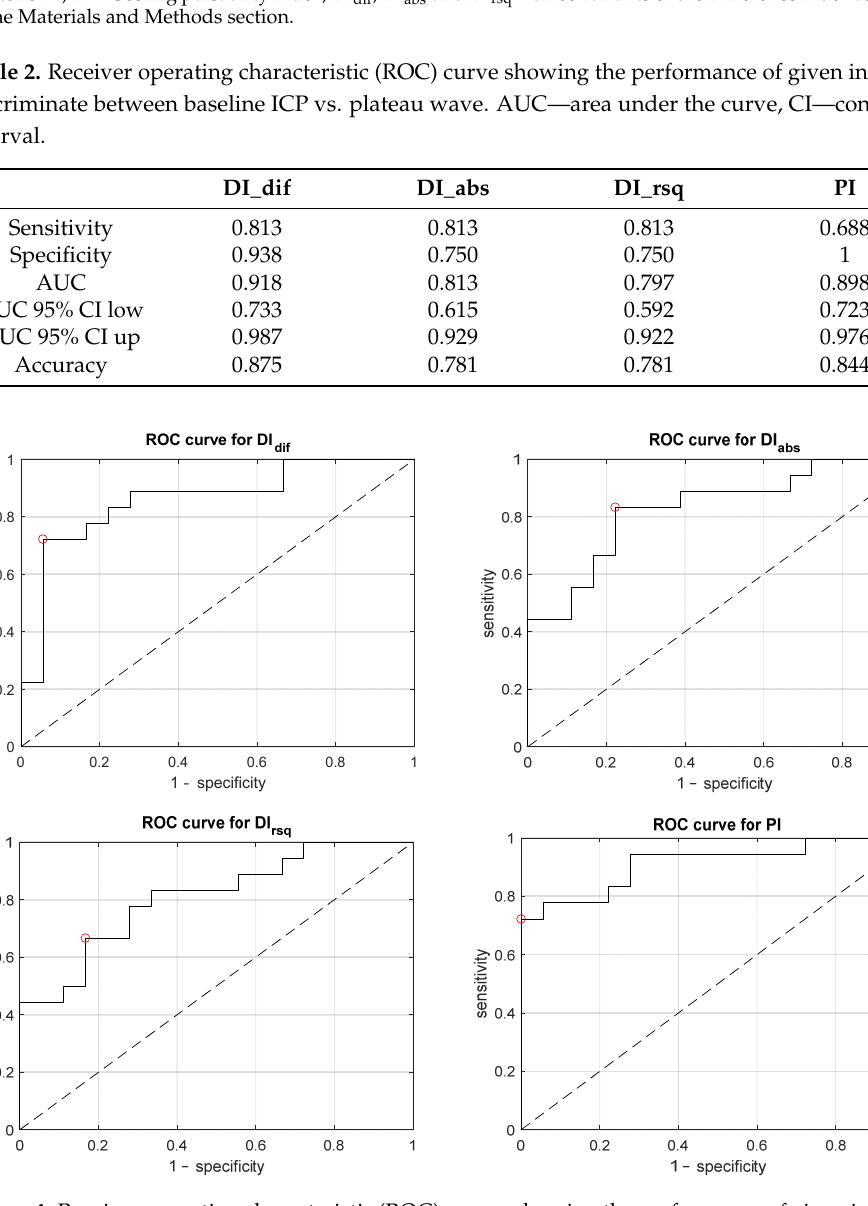
Figure 4. Receiver operating characteristic (ROC) curves showing the performance of given indices to discriminate between baseline ICP vs. plateau wave. The circle denotes the optimal operating point. Table 1. Basic characteristics of physiological parameters at baseline and during ICP plateau wave. Baseline Plateau (Mean ± Std. Dev.) (Mean ± Std. Dev.)